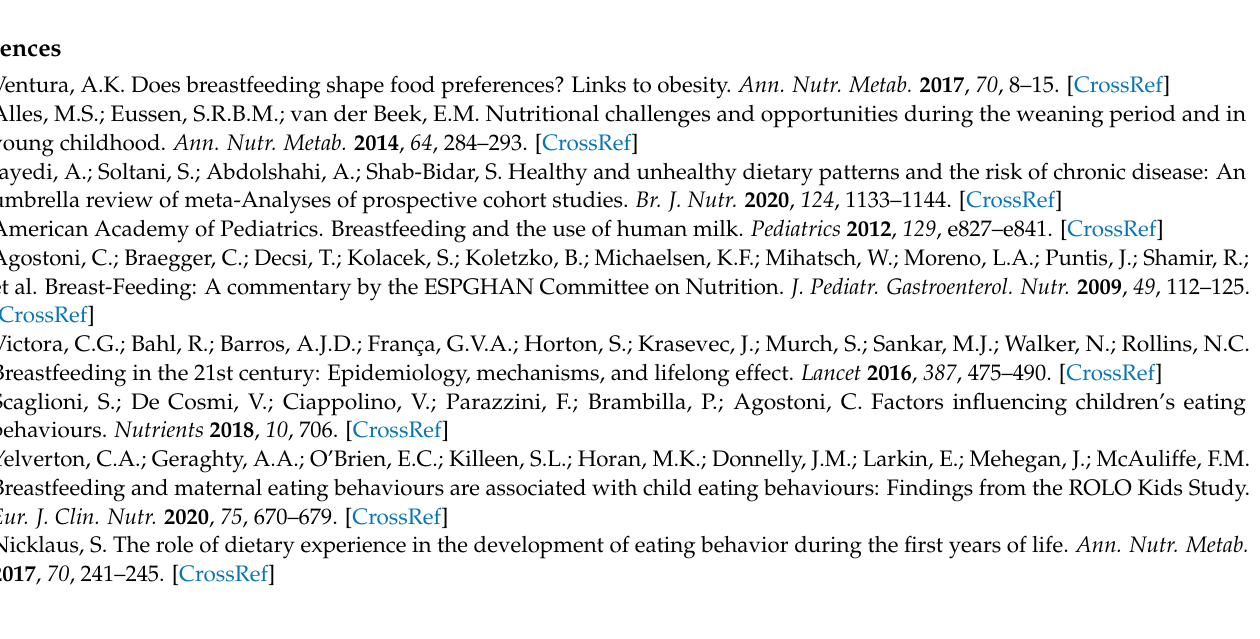
pattern; Table S4: Birth-related factors, maternal BMI and ever formula feeding according to CEBQ results; Table S5: Univariate regression analysis predicting eating